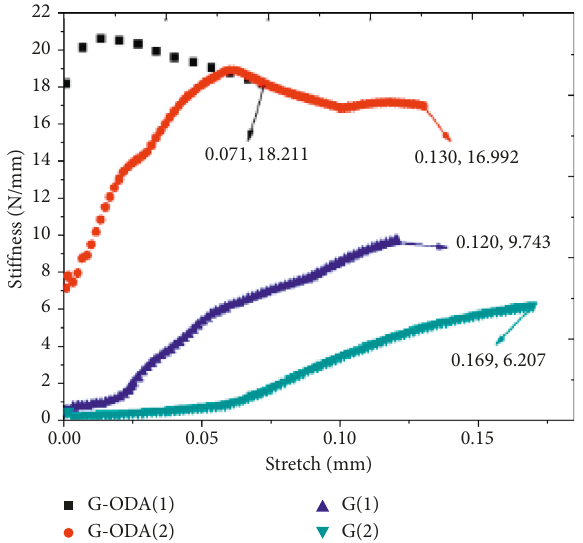
Figure 3: Stiffness vs stretch of GP and G-ODA strips [24].